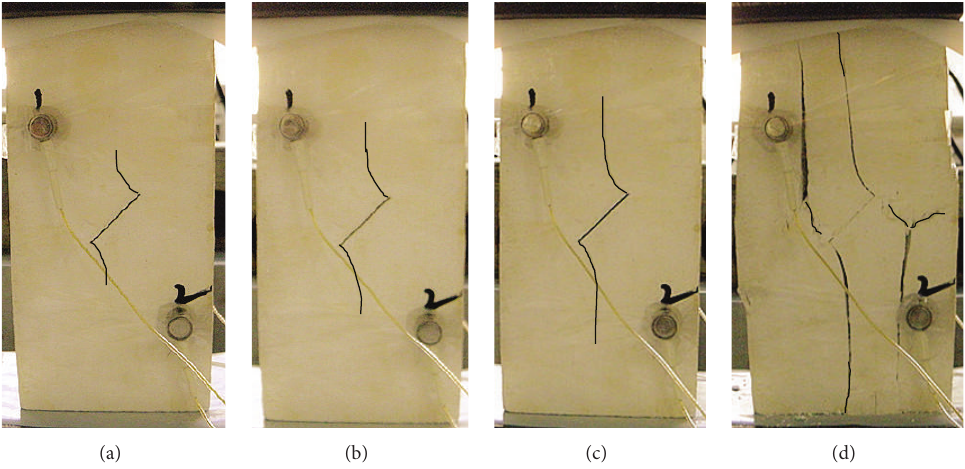
Figure 9: Fracture propagation process of specimen E. (a) 𝜎 = 81.4 % 𝜎 𝑠 . (b) 𝜎 = 86.3 % 𝜎 𝑠 . (c) 𝜎 = 92.3 % 𝜎 𝑠 . (d) 𝜎 = 100 % 𝜎 𝑠 .